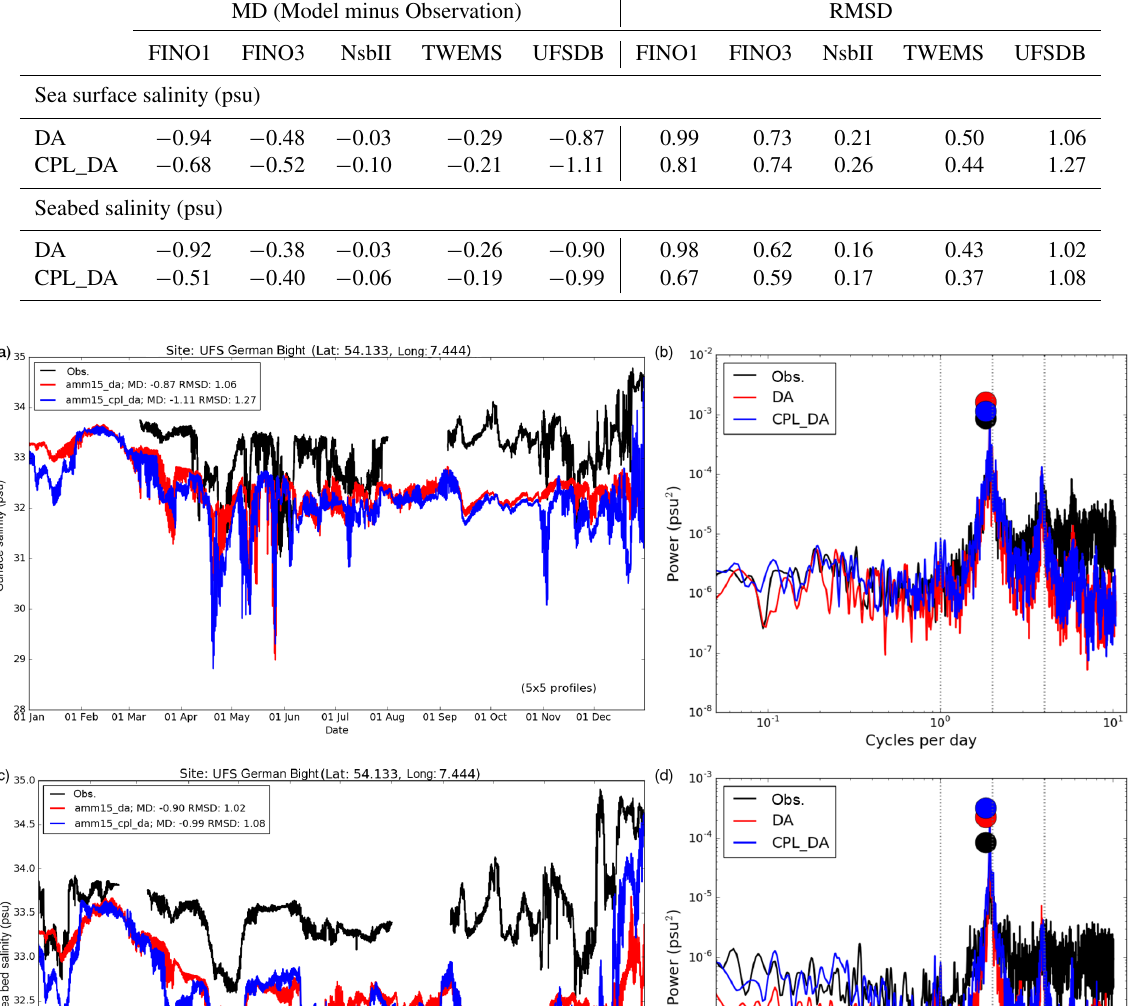
Table 5. Summary statistics comparing DA and CPL_DA results for sea surface salinity (SSS) and seabed salinity (SBS) with co-located observations during 2017 at sites in the German Bight (starred symbols in Figs. 3a and 11b, c).